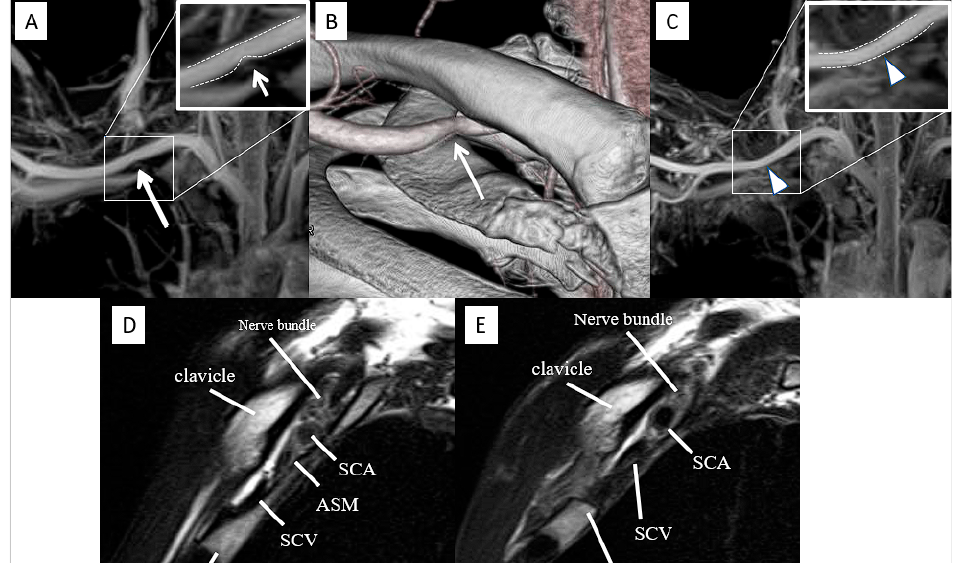
Figure 6. Preoperative and postoperative images. ( A ) Preoperative MRI-MIP image showing grade 1 stenosis of the SCA (arrow). ( B ) Preoperative 3D-CT angiography showing stenosis from below at the site where the SCA meets the clavicle (arrow). ( C ) Postoperative MRI-MIP image revealing stenosis of SCA disappeared and identified as grade 0 (arrowhead). ( D ) Preoperative sagittal view shows that the anterior scalene muscle is in contact with the SCA, and the SCV is disrupted. ( E ) Preoperative sagittal view shows that the first rib was resected, and the anterior scalene muscle, which was in contact with the SCA, was absent. Stenosis of the SCV remained. MRI-MIP, magnetic resonance imaging maximum-intensity projection; SCA, subclavian artery; SCV, subclavian vein.